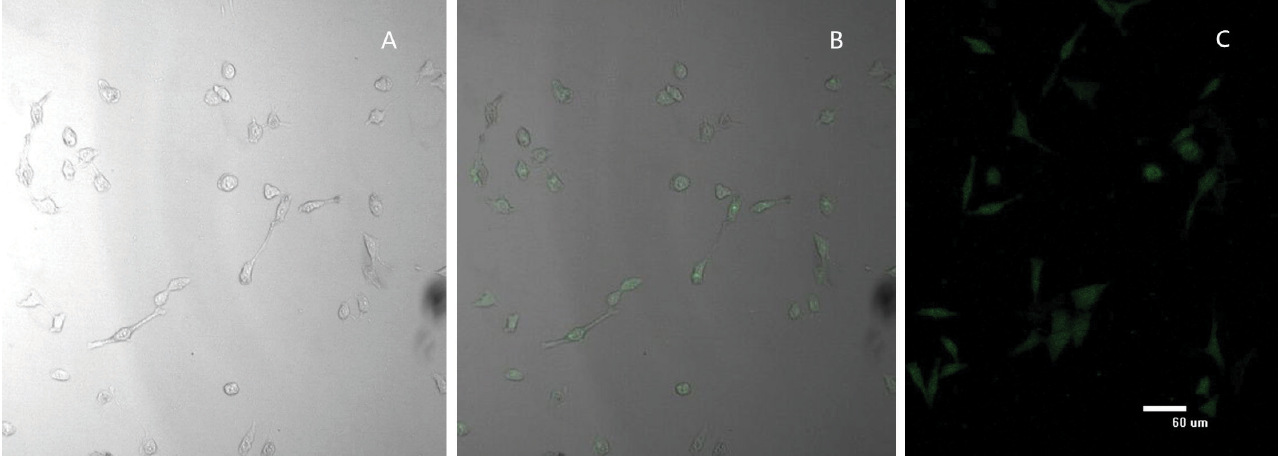
FIGURE 5 - Confocal laser scanning microcopy images show the internalization of fluorescent nanoparticles in cells. (A) MCF-7 cells with no drug incubation. (B) MCF-7 cells incubated with DTX-BSA-NPs for 2 h. (C) MCF-7 incubated with DTX-BIO- BSA-NPs for 2 h. DTX-BIO-BSANP, docetaxel-loaded biodegradable bovine serum albumin nanoparticles with biotin decoration; DTX-BSA-NPs, docetaxel-loaded biodegradable bovine serum albumin